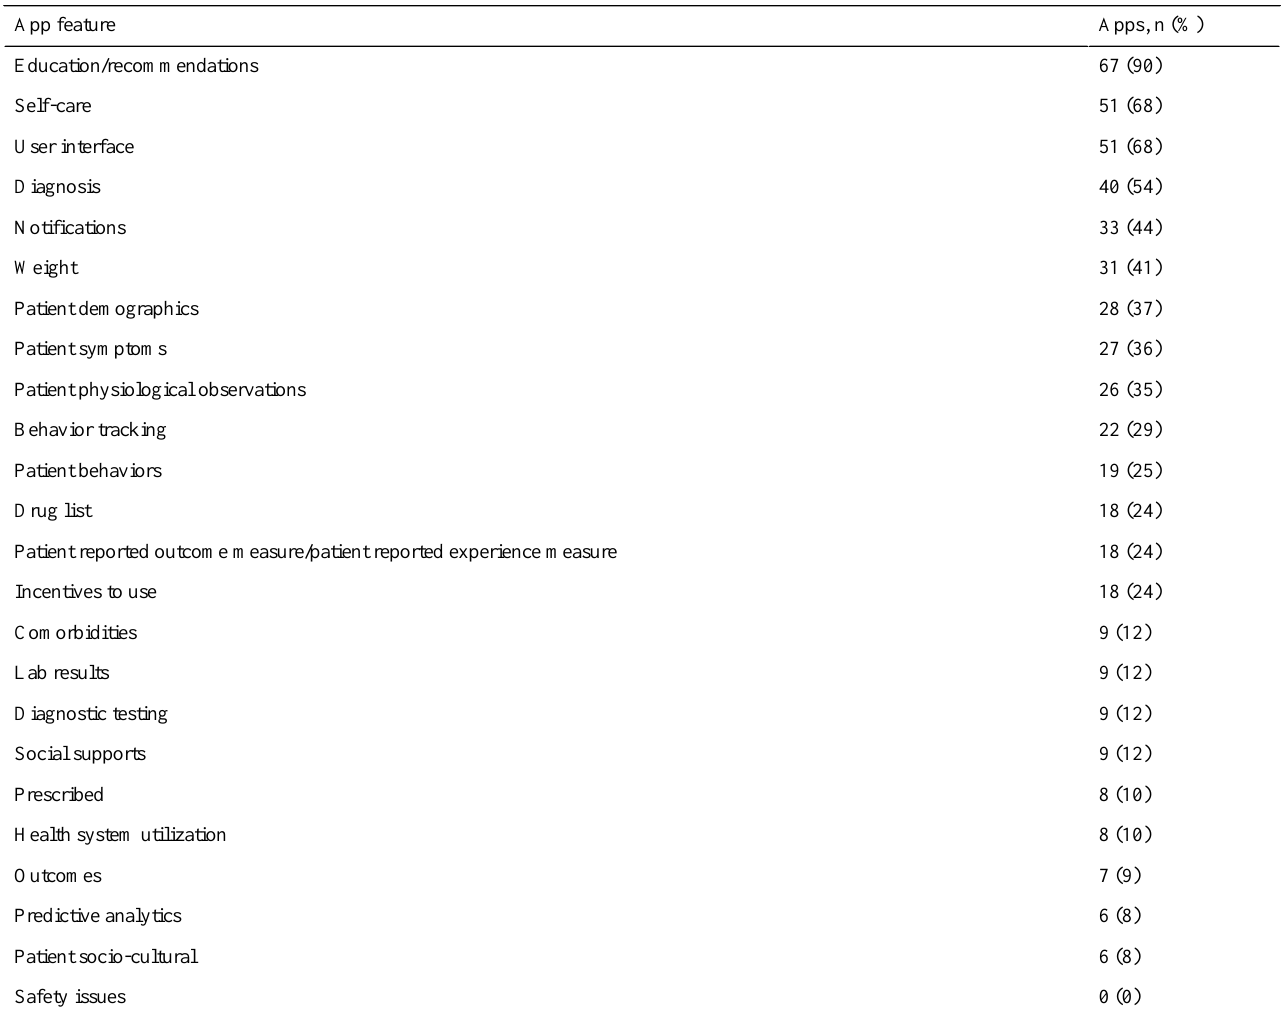
Table 2. Features present in the reviewed heart failure self-care apps